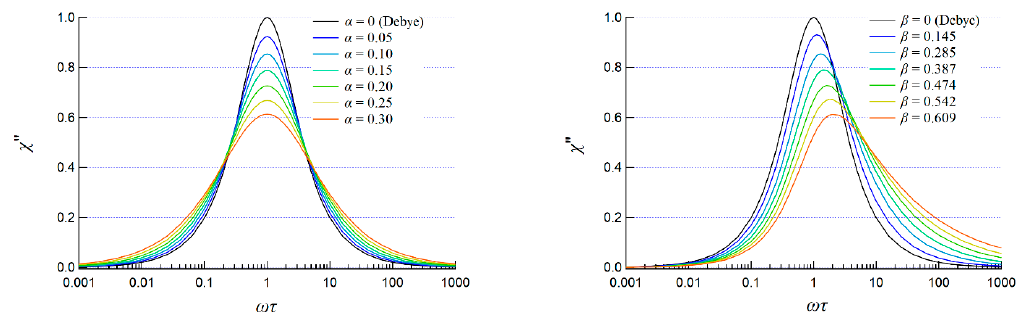
Figure 6. Theoretical curves of the out-of-phase susceptibility χ ″ as a function of ωτ for several α values ( left ) or β values ( right ), calculated on the basis of the Cole–Cole and Cole–Davidson equations. At α = 0 and β = 0, both plots obey Debye equation. The value of χ ″ was normalized as 1.0 at ωτ = 0 and α = 0 for the left plot and at ωτ = 0 and = 0 for the right plot.